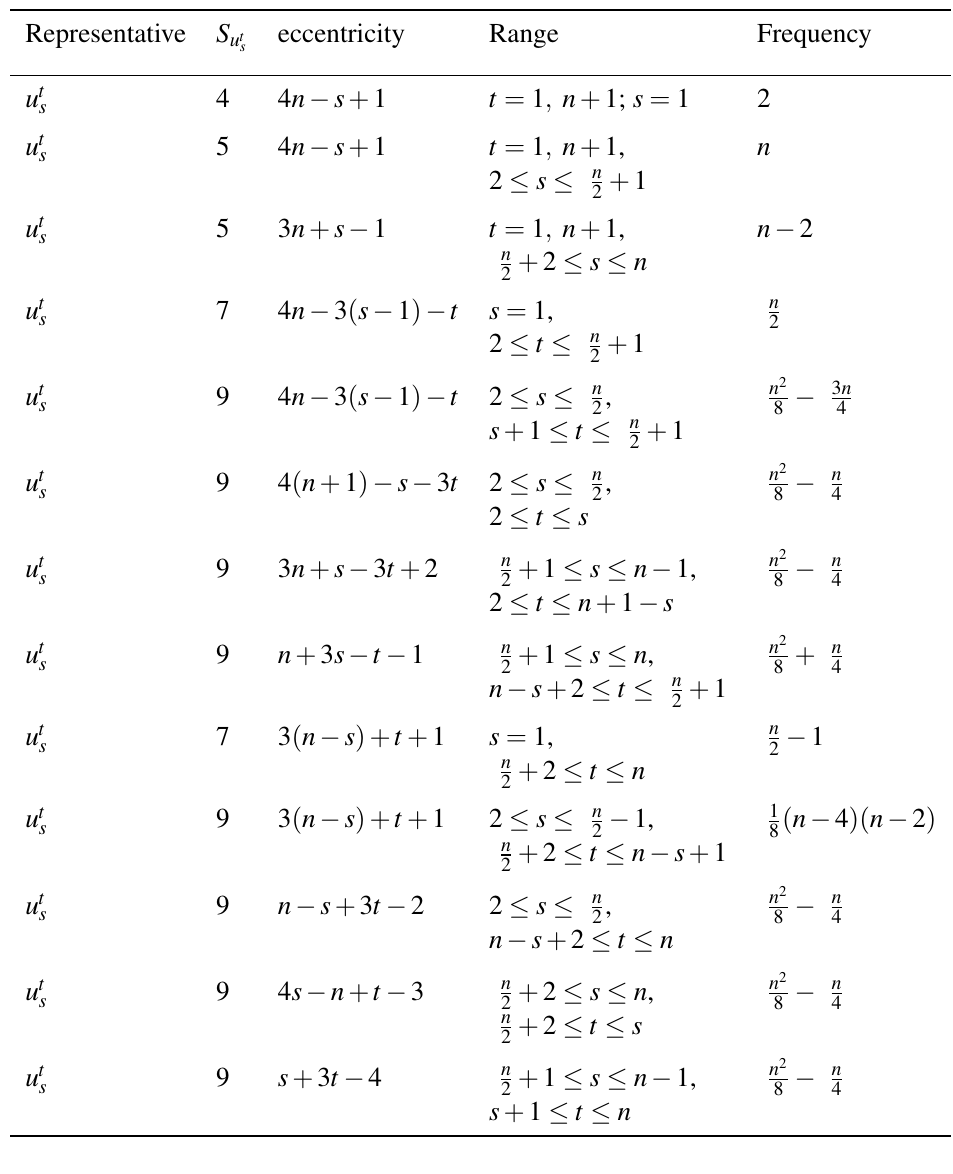
of O m based on degree sum and eccentricity of each vertex when n ≡ 0 ( s n